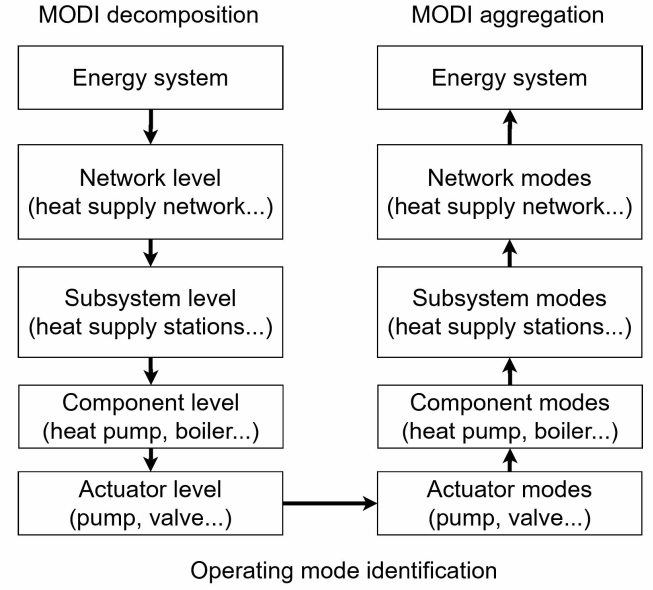
Figure 1. Strategy of the MODI